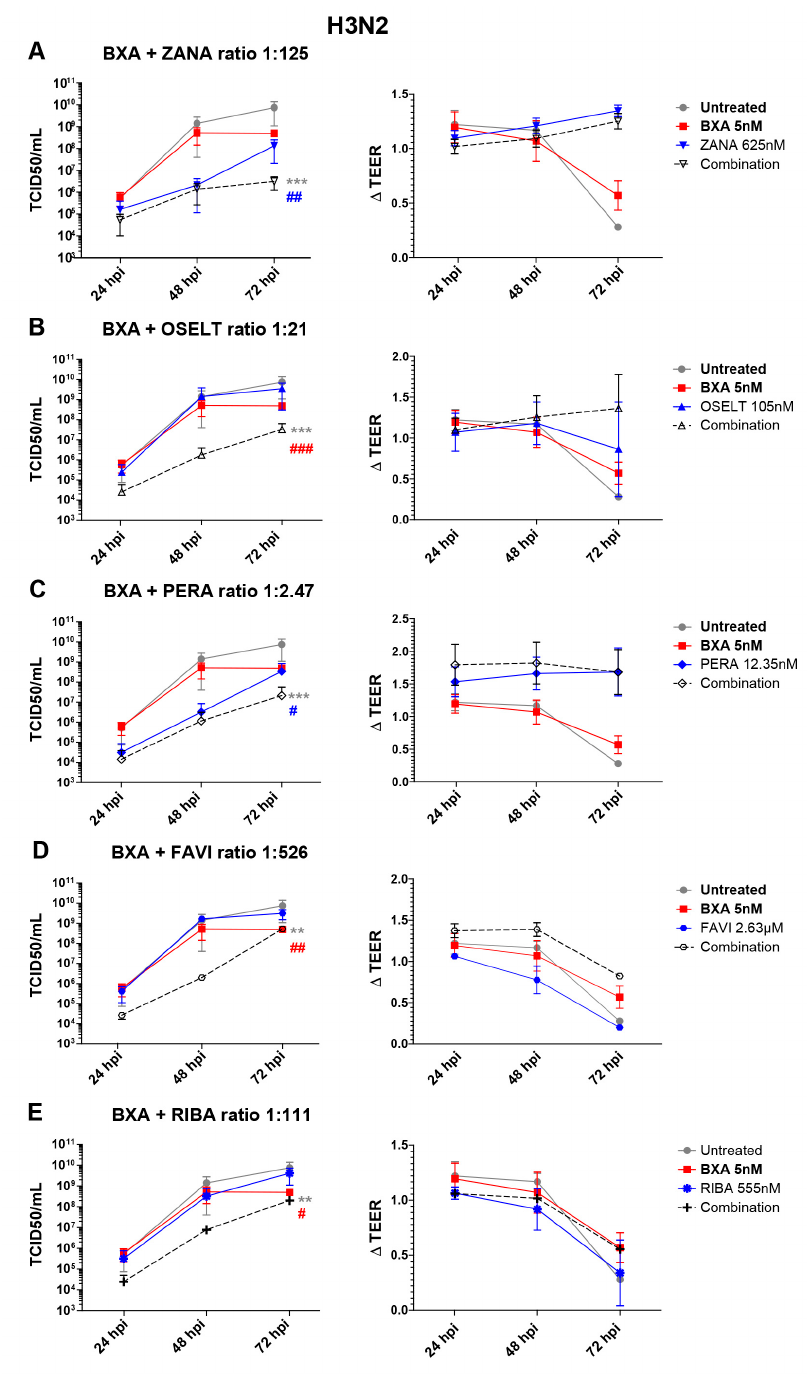
Figure 2. Two-drug combination activity in influenza A(H3N2)-infected reconstituted human airway epithelia (HAE). Apical viral production (TCID50 / mL ± SD) and transepithelial electrical resistance ( ∆ TEER vs. t = 0 ± SD) in MucilAirTM HAE infected on the apical pole with influenza A / Texas / 50 / 2012 (H3N2) virus at a MOI of 0.01 and treated by the basolateral pole with the indicated antiviral combinations and their corresponding single drug controls: ( A ) baloxavir acid + zanamivir; ( B ) baloxavir acid + oseltamivir; ( C ) baloxavir acid + peramivir; ( D ) baloxavir acid + favipiravir; ( E ) baloxavir acid + ribavirine. ** p < 0.01 and *** p < 0.001 and # p < 0.05, ## p < 0.01 and ### p < 0.001 compared to the infected untreated or the most performant single-treated groups (BXA (# in red) and ZANA, or PERA (# in blue)), respectively, using mixed model two-way analysis of variance (ANOVA) with Bonferroni post hoc test. Data are representative of at least three independent